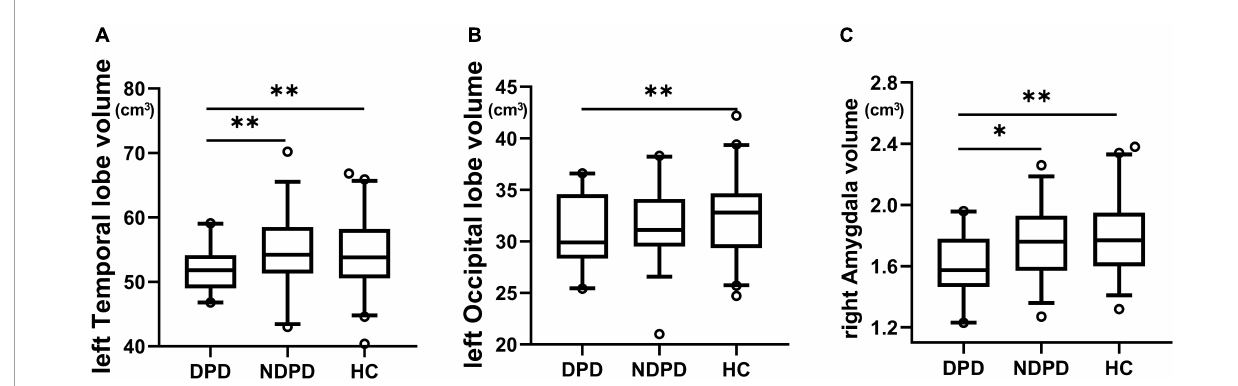
FIGURE3 Box-and-whiskers plots for brain regions exhibiting significant differences in GM volumes. (A) The left temporal lobe, (B) the left occipital lobe, (C) the right amygdala. The boxes display the median and the 25th and 75th quartiles, whiskers showing the 5th and the 95th percentile. The outlier is shown as a data point outside of the box. ∗ Post hoc P -value < 0.05, ∗∗ Post hoc P -value < 0.01, Bonferroni corrected.